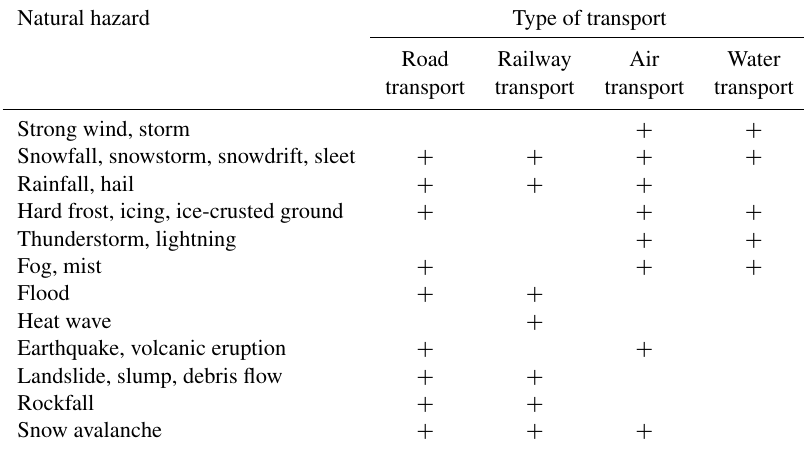
Table 1. Transport accidents and traffic disruptions caused by natural hazards in Russia (1992–2018). Natural hazard Type of transport Road Strong wind, storm + + Snowfall, snowstorm, snowdrift, sleet + + + + Rainfall, hail + + + Hard frost, icing, ice-crusted ground + + + Thunderstorm, lightning + + Fog, mist + + + Flood + + Heat wave + Earthquake, volcanic eruption + + Landslide, slump, debris flow + + Rockfall + + Snow avalanche + +